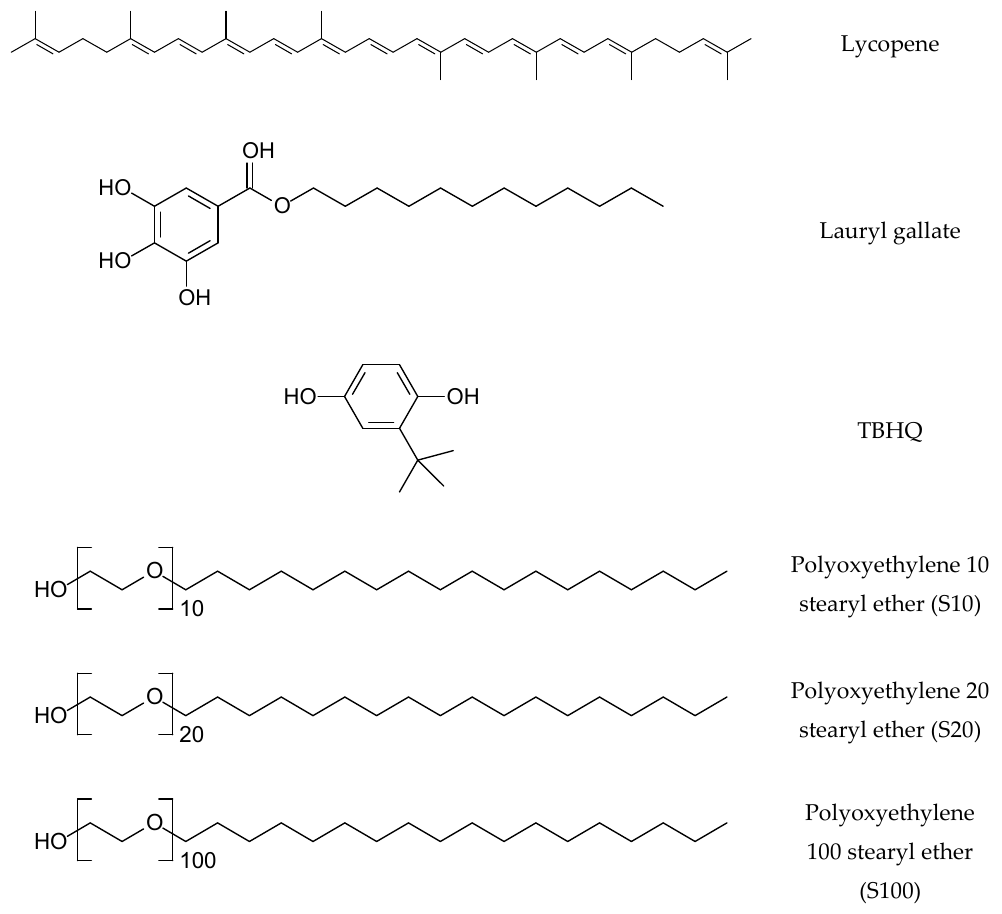
Figure 1. Molecular structures of lycopene, lauryl gallate, TBHQ, and polyethylene glycol acyl-type emulsifies used in this study.